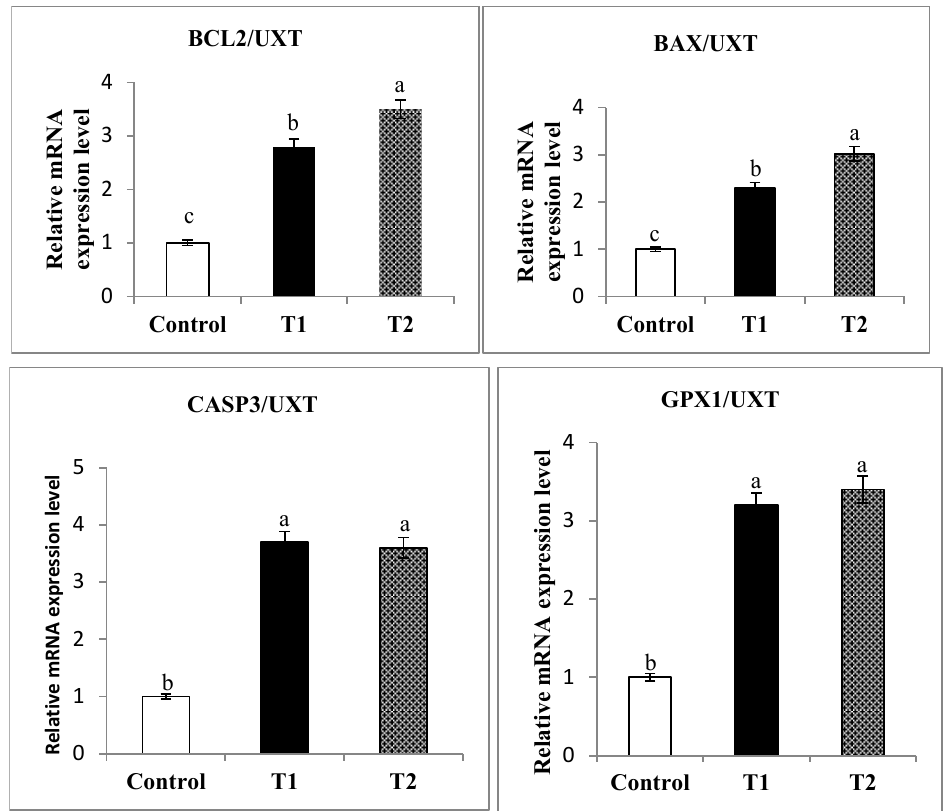
Figure 1. The qRT-PCR validation of mRNA expression for BAX/UXT, BCL2/UXT, CASP3/UXT, and GPX1/UXT in liver tissue; cell lymphoma2: BAX/UXT+ BCL2/UXT ; caspase: CASP3/UXT ; glutathione peroxidase: GPX1/UXT . a,b,c values in the same box with a different superscript differ significantly at p < 0.05.